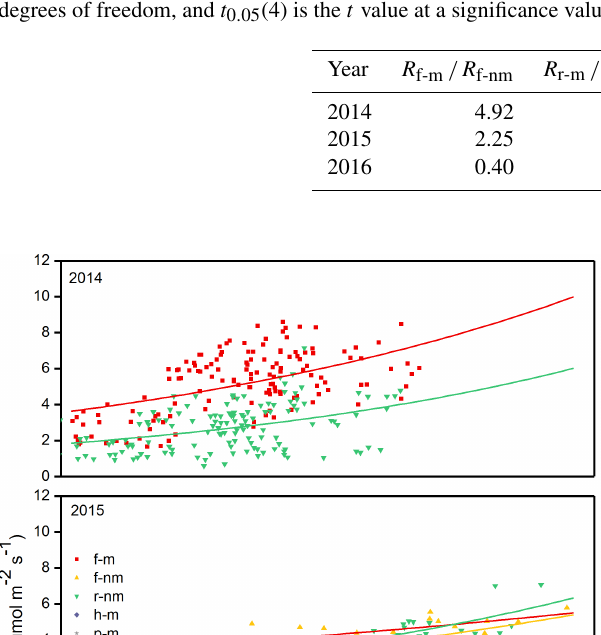
Table 1. The t test of significance was conducted for soil respiration in furrows and ridges and total soil respiration between mulched and non-mulched fields ( R m and R nm represent the total soil respiration in mulched and non-mulched fields, respectively. df represents the degrees of freedom, and t 0 . 05 (4) is the t value at a significance value of 0.05 and a df of 4).